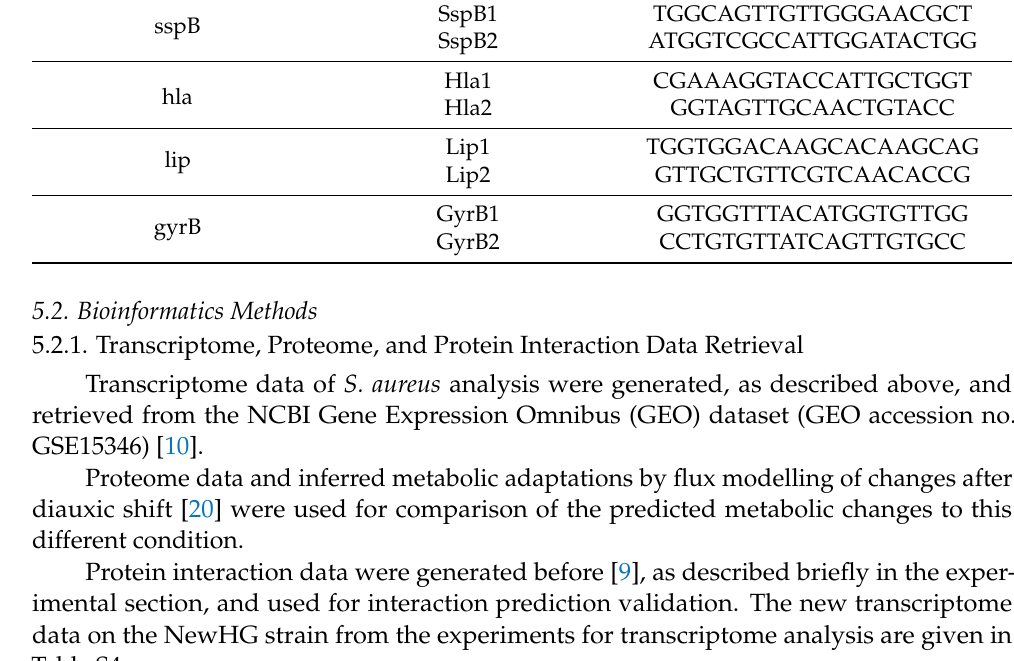
Table 4. Cont. Gene